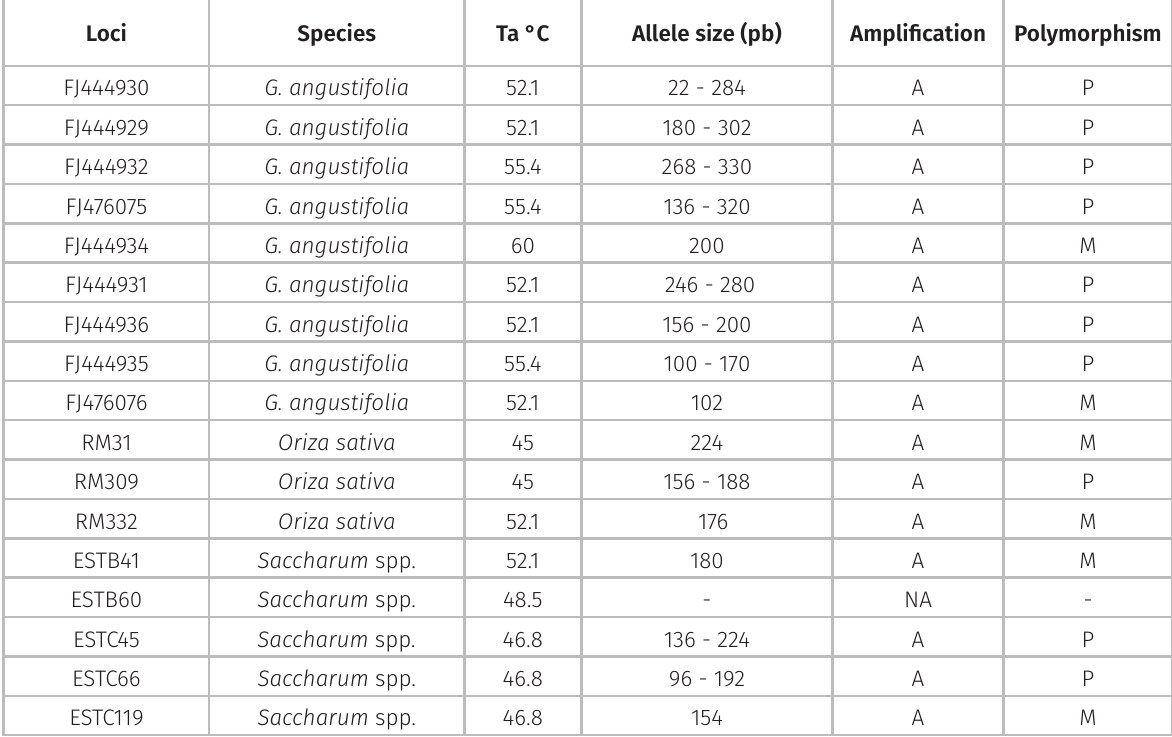
Table III. Loci transferred to the species Guadua aff. chaparensis and G. aff. lynnclarkiae .